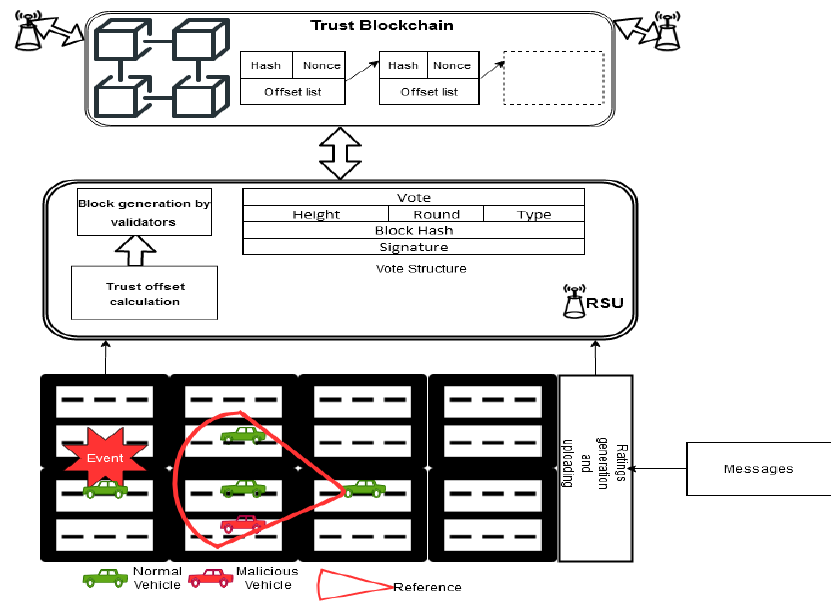
Figure 2. Proposed blockchain-based system model for trust management system.